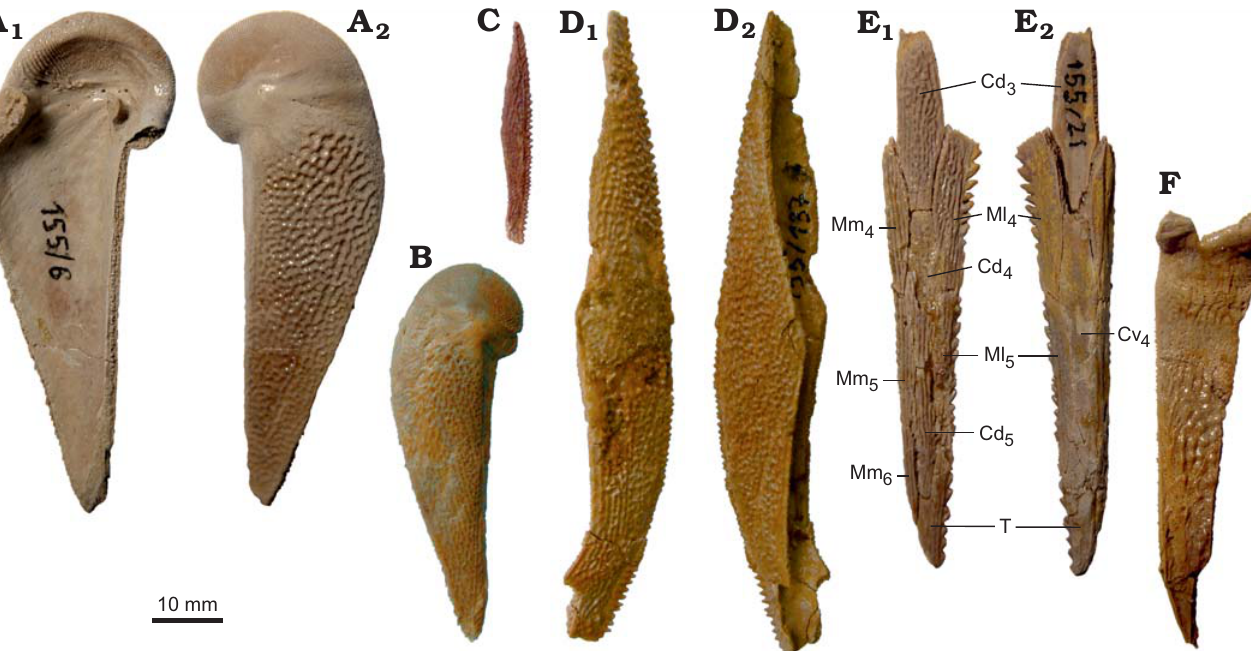
Fig. 13. Antiarchan fish Bothriolepis leptocheira jeremejevi (Rohon, 1900), Sosnogorsk locality, Sosnogorsk Formation, lowermost Famennian, plates of the pectoral fin armour. A . Left Cv 1 plate IG 155/6 in visceral (A 1 ) and ventral (A 2 ) views. B . Right Cv 1 plate IG KSC 155/134 in ventral view. C . Left Ml 2 plate IG KSC 155/149 in ventral view. D . Right Ml 2 plate IG 155/137 in dorsal (D 1 ) and ventral (D 2 ) views. E . Right distal segment of the pectoral fin armour IG KSC 155/21 in dorsal (E 1 ) and ventral (E 2 ) views. F . Mm 1 plate IG KSC 155/85 in mesial view. Abbreviations: Cd 3–5 , dorsal central plates 3 to 5; Cv 4 , ventral central plate 4; Ml 4–5 , lateral marginal plates 4 and 5; Mm 4–6 , mesial marginal plates 4 to 6; T, terminal and B. leptocheira curonica (Lukševi č s 2001: figs. 37F, G,